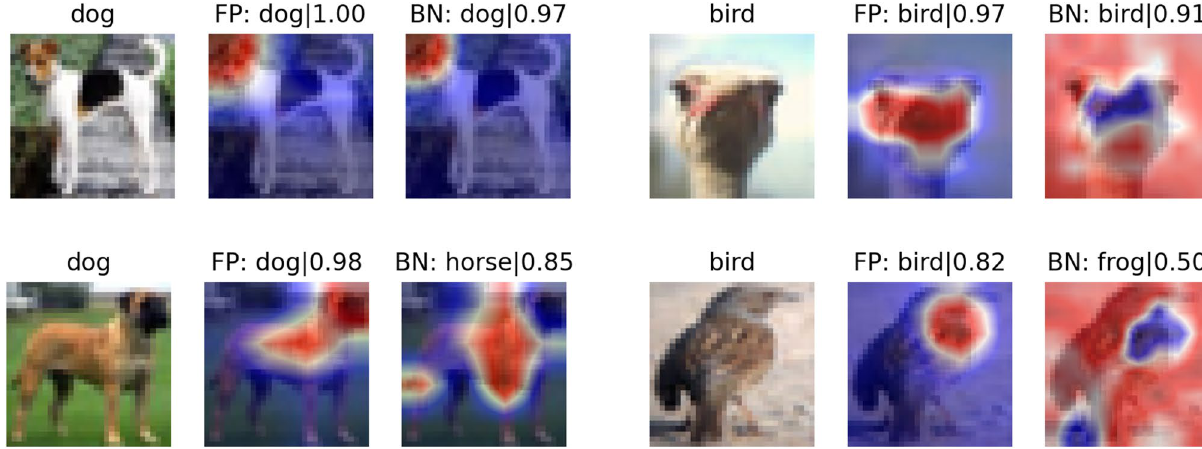
Figure 3. Grad-CAM/CAM of VGG-Small (left) and ResNet-20 (right). In the top row, the images are correctly classified for both full-precision (FP) and full-binary (BN) network, therefore they identify the same defining part of the image. In the bottom row, the images are mis-identified by full-binary network, therefore the BN gives different defining part from the FP network. The numbers are the confidence. Notice that for binary ResNet-20 everything gets